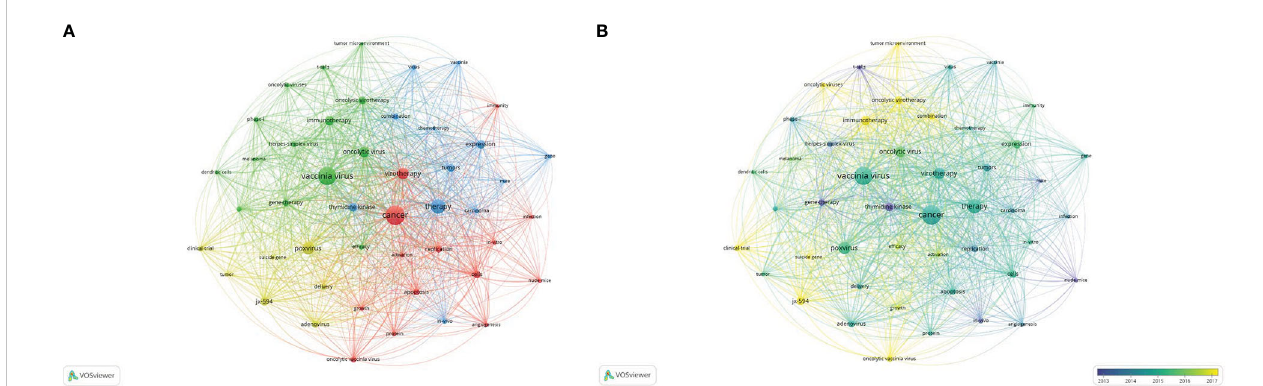
FIGURE 6 Research status and development trend. (A) The 47 keywords that arose more than 16 times were divided into three clusters, represented by different colors. The sizes of the nodes represent the frequency of occurrences. (B) Visualization of keywords according to the average publication year. Keywords in yellow appeared later than those in blue (color fi gure online).